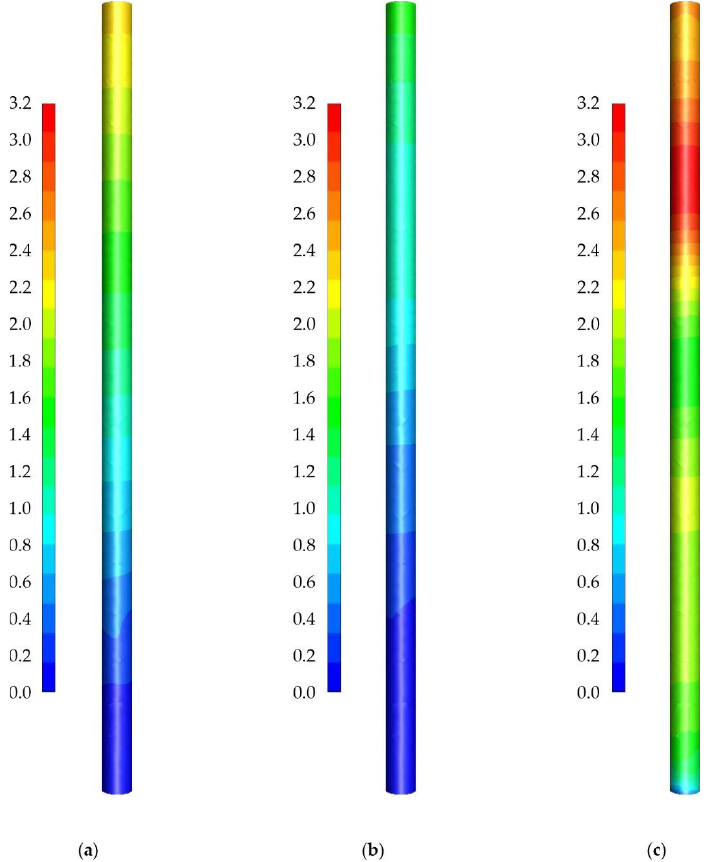
Figure 6. Mass fraction of side reaction products for the case of a catalyst mass of 100 g, a gas velocity of 0.016 m/s, and temperature of 575 °C: ( a ) CH 4 ; ( b ) C 3 H 6 ; and ( c ) C 3 H 8 . Methane and propylene were formed from isobutane at the top of the reactor in the thermal cracking reaction of isobutane. The formation of these components mainly oc- curred in the absence of a catalyst, since in the catalyst bed isobutane was mainly spent on the dehydrogenation reaction. The mass fraction of side reaction products in the gas mixture in the reactor did not exceed 7%.